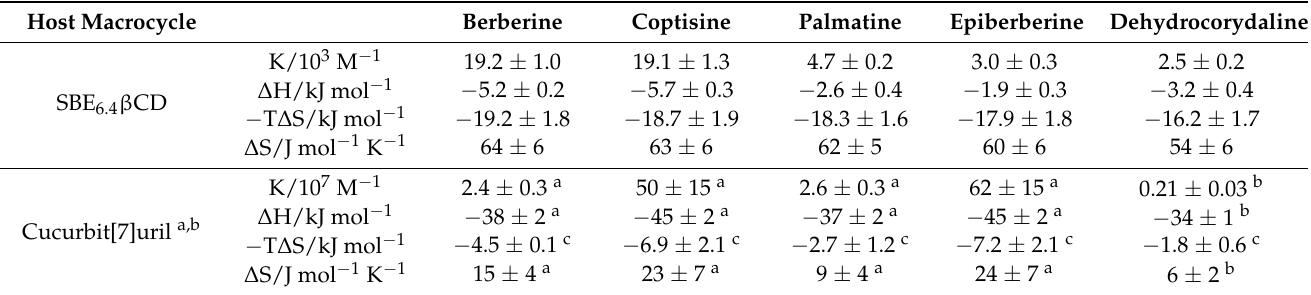
Table 1. Binding constants and thermodynamic parameters for the 1:1 encapsulation of